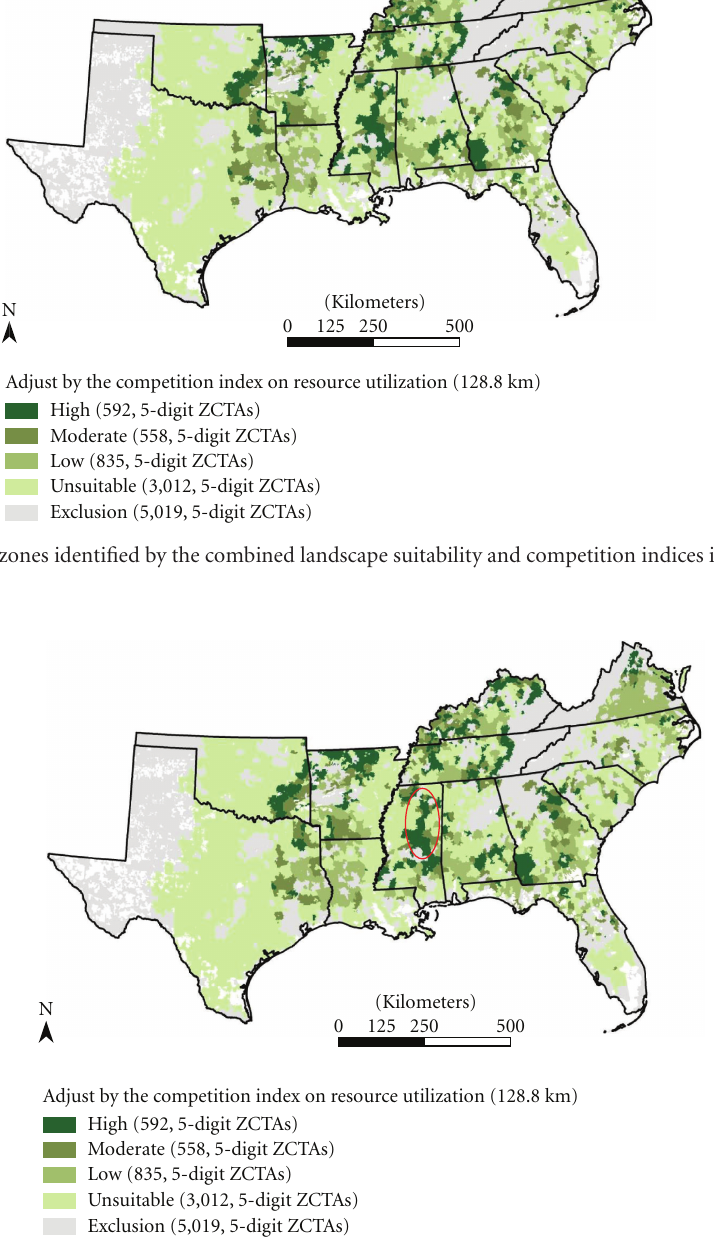
Figure 7: Opportunity zone in central Mississippi (highlighted in red) for mill location at ZCTA 39090 (Kosciusko MS).